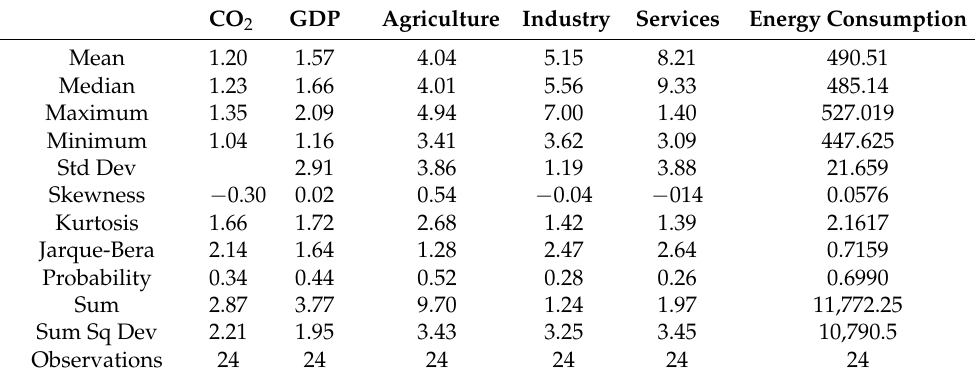
Table A1. Descriptive analysis.